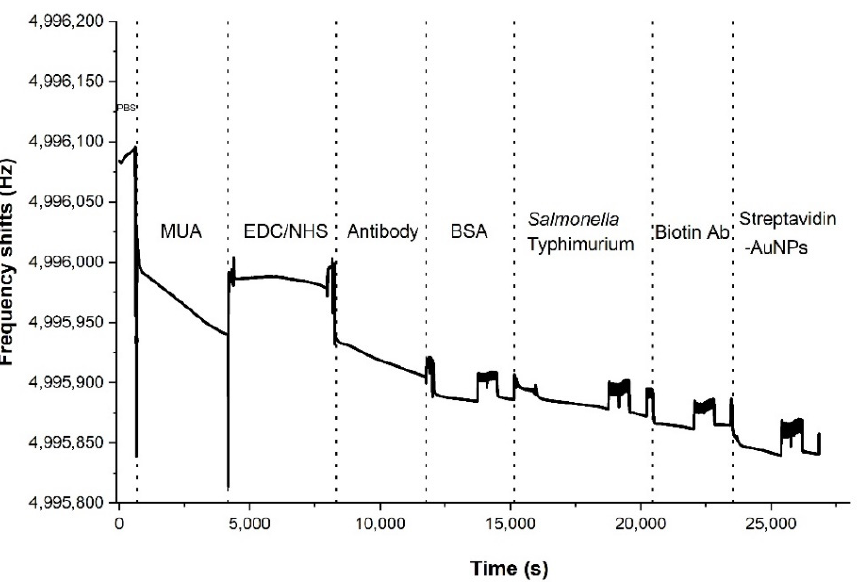
Figure 6. Total resonant frequency responses for a single measurement result from the whole procedure for Salmonella detection. Each material was indicated when the solution was replaced.